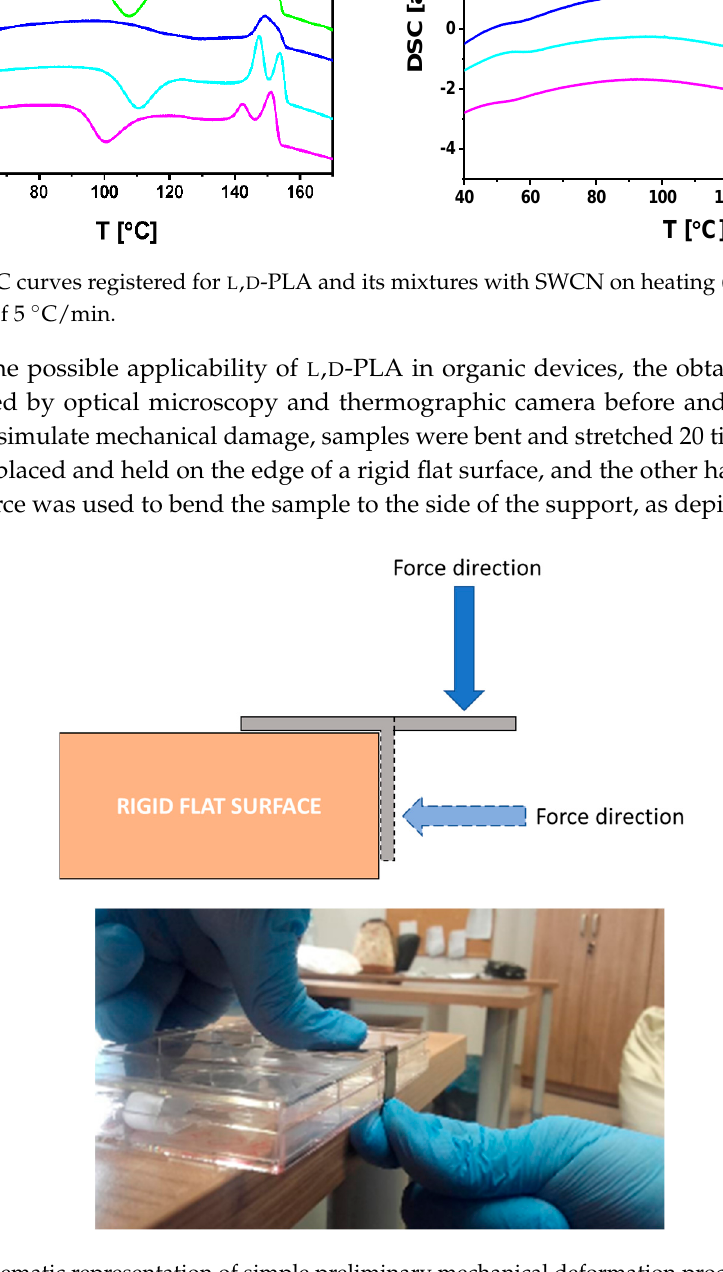
Figure 5. Schematic representation of simple preliminary mechanical deformation procedure together with photo of deformation of L , D -PLA film with SWCN.